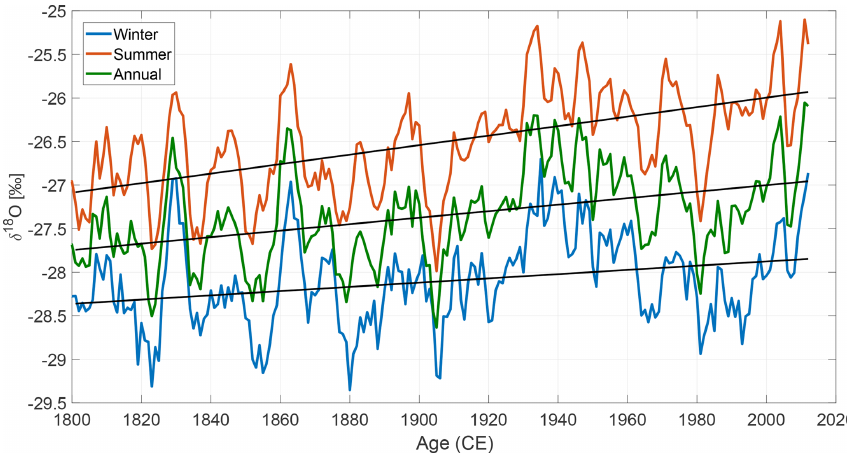
Figure 3. Summer (red), winter (blue) and annually averaged (green) δ 18 O stacks together with their corresponding linear trends (black lines) for the period 1801–2014. A moving average of 5 years has been applied to all the time series. For the unfiltered series, the reader is referred to Figs. 4, C2 and C3.